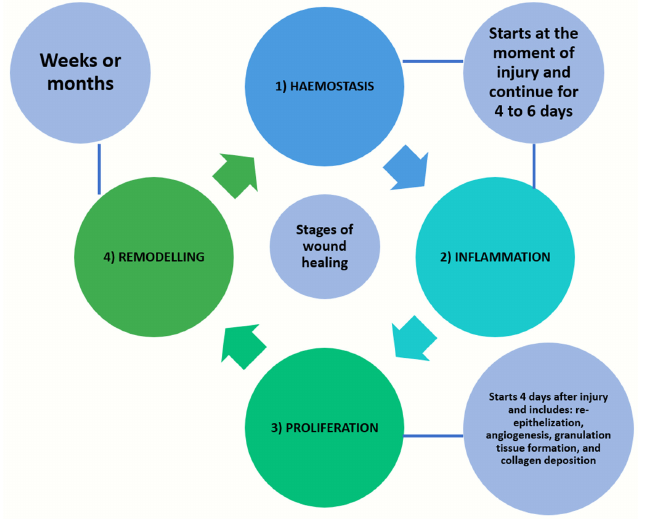
Figure 2 . Four stages of tissue change sequences in wound healing, namely haemostasis, inflamma- tion, proliferation, and remodelling.